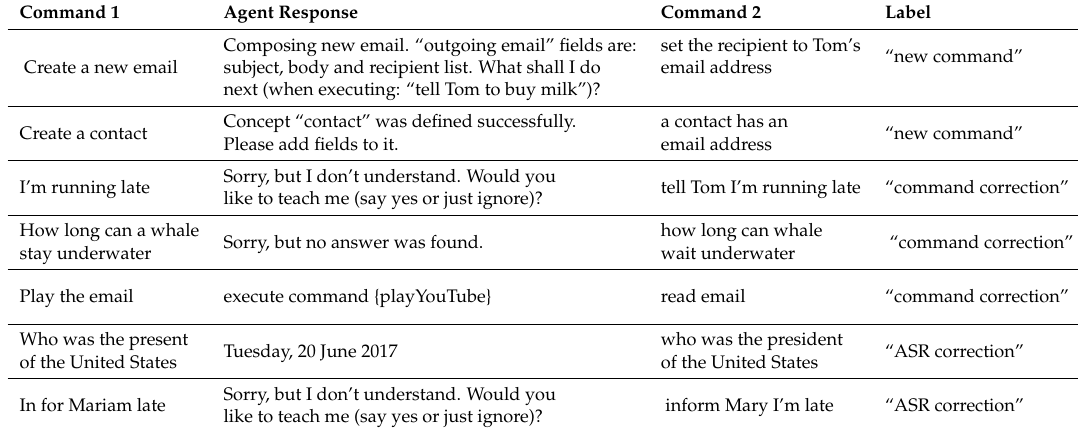
Table 1. Dataset